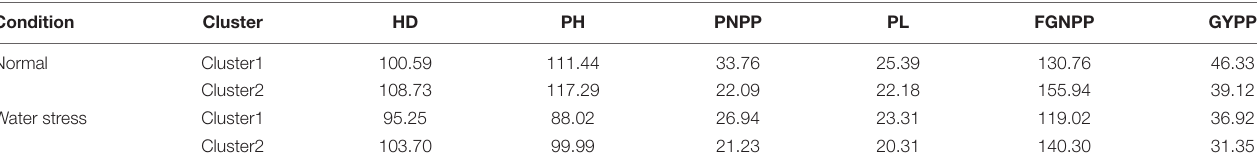
TABLE 7 | Average of the traits studied for the two clusters under normal and water stress conditions.